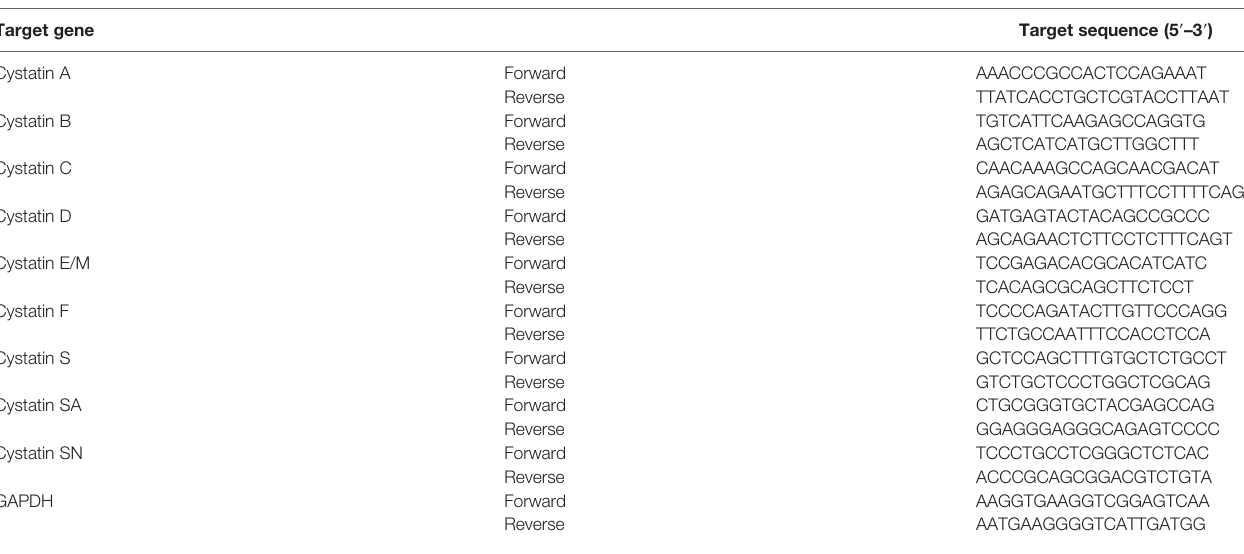
TABLE 1 | List of qPCR primers. Target gene Target sequence (5 ′ – 3 ′